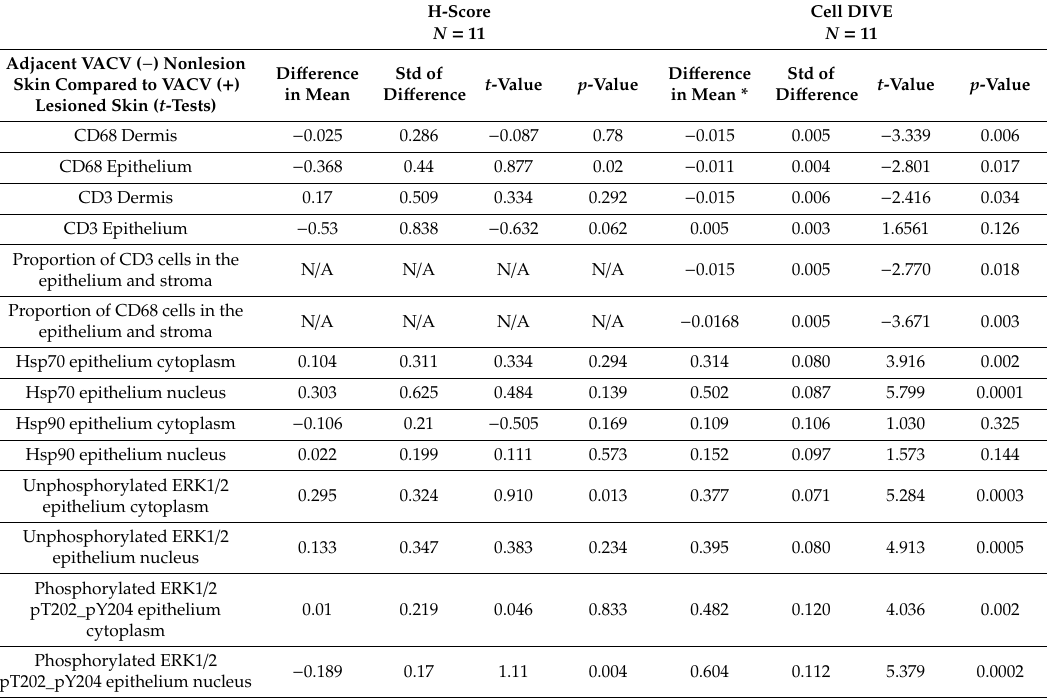
Table 3. Biomarkers di ff erentially expressed between monkeypox virus-infected and adjacent nonlesion skin regions using IHC and Cell